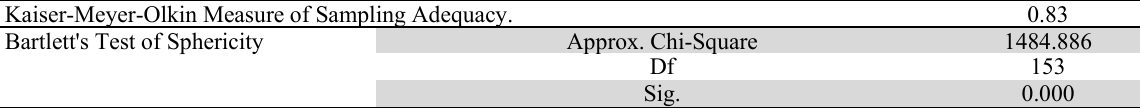
The results of KMO and Bartlett's Test Kaiser-Meyer-Olkin Measure of Sampling